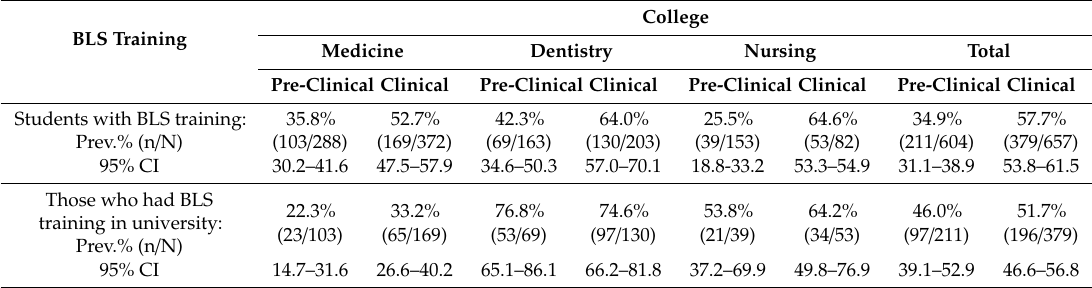
Table 1. Prevalence (%) and 95% CI of basic life support (BLS) training among health profession students at King Khalid University.